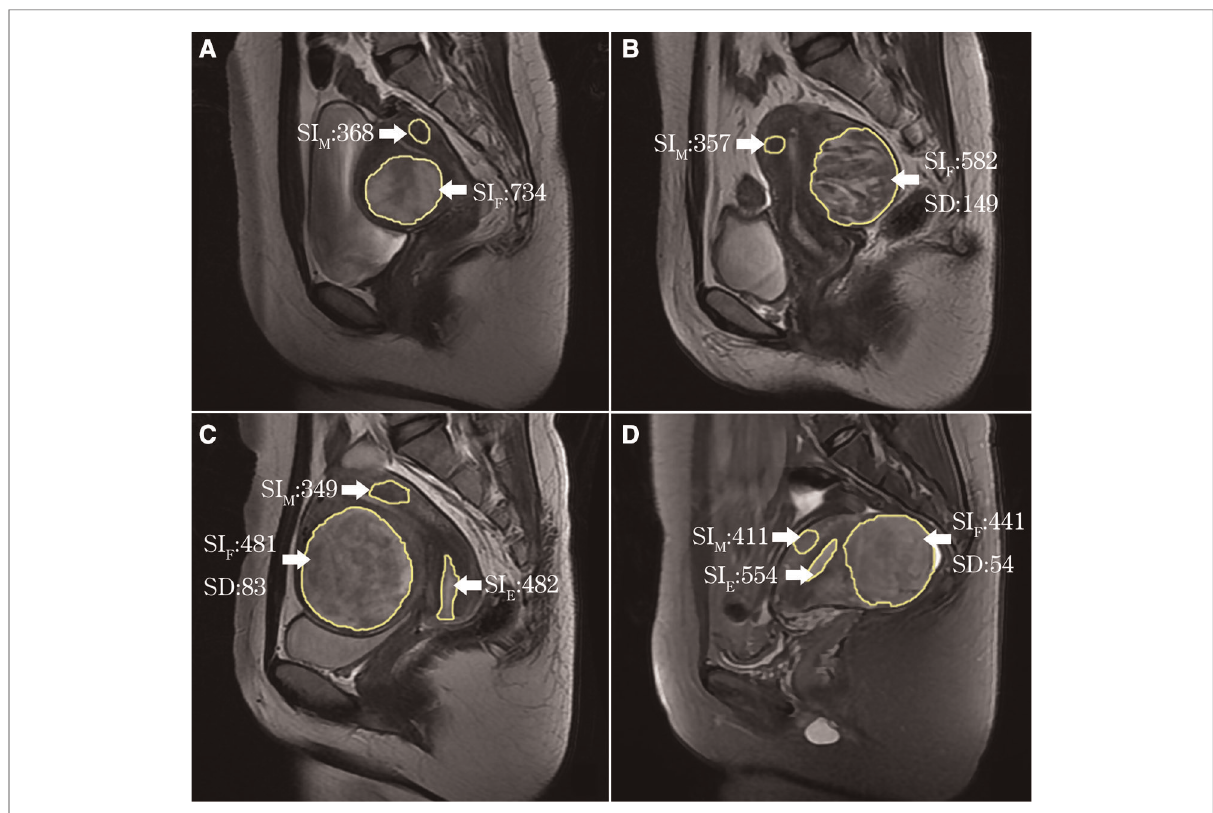
FIGURE 1 ROI delineation and measured value output on T2WI by the software (yellow line). ( A ) Uterine fi broids and myometrium ROI delineation and SI value output: SI F >SI M ; ( B ) HHF: SD=149, SI F ≥ SI M ; ( C ) mHHF: SD=83, SI F ≈ SI E >SI M ; ( D ) sHHF: SD=54, SI M ≤ SI F <SI E